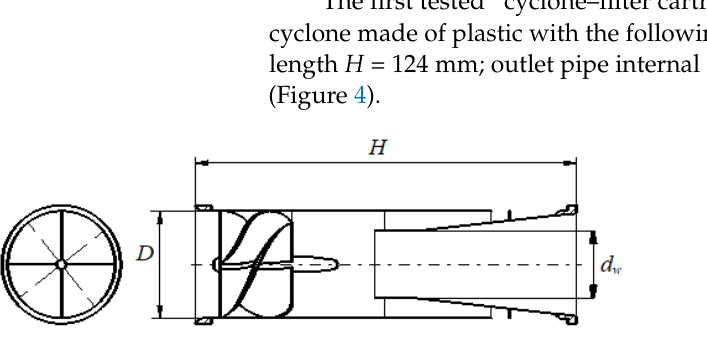
Figure 4. Axial flow cyclone of the “filter set”.